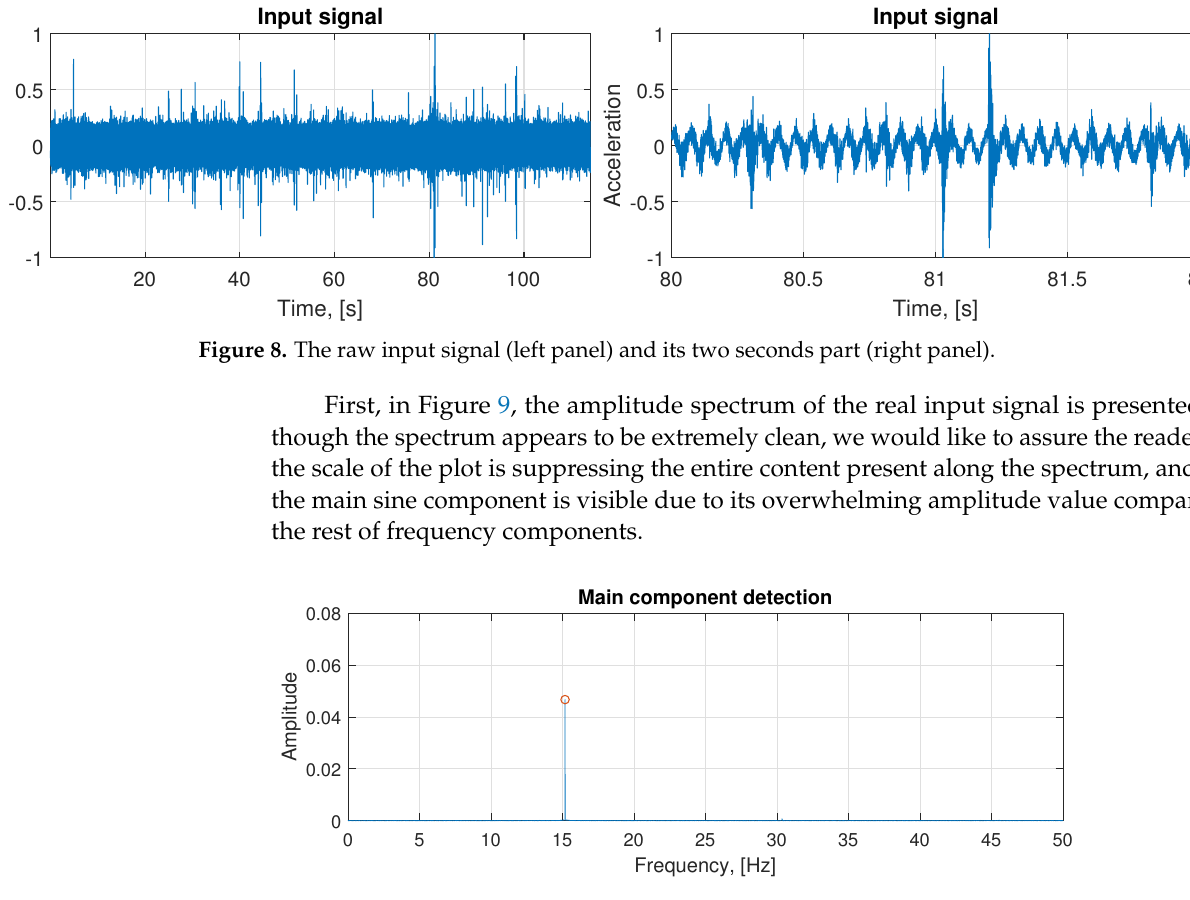
Figure 9. Main sine component detected in the signal clearly visible on the Fourier